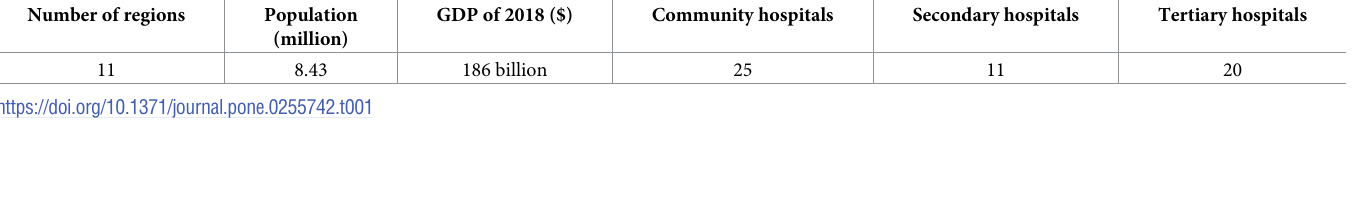
Table 1. Main characteristics of Nanjing’s survey districts and number of sample facilities. Number of